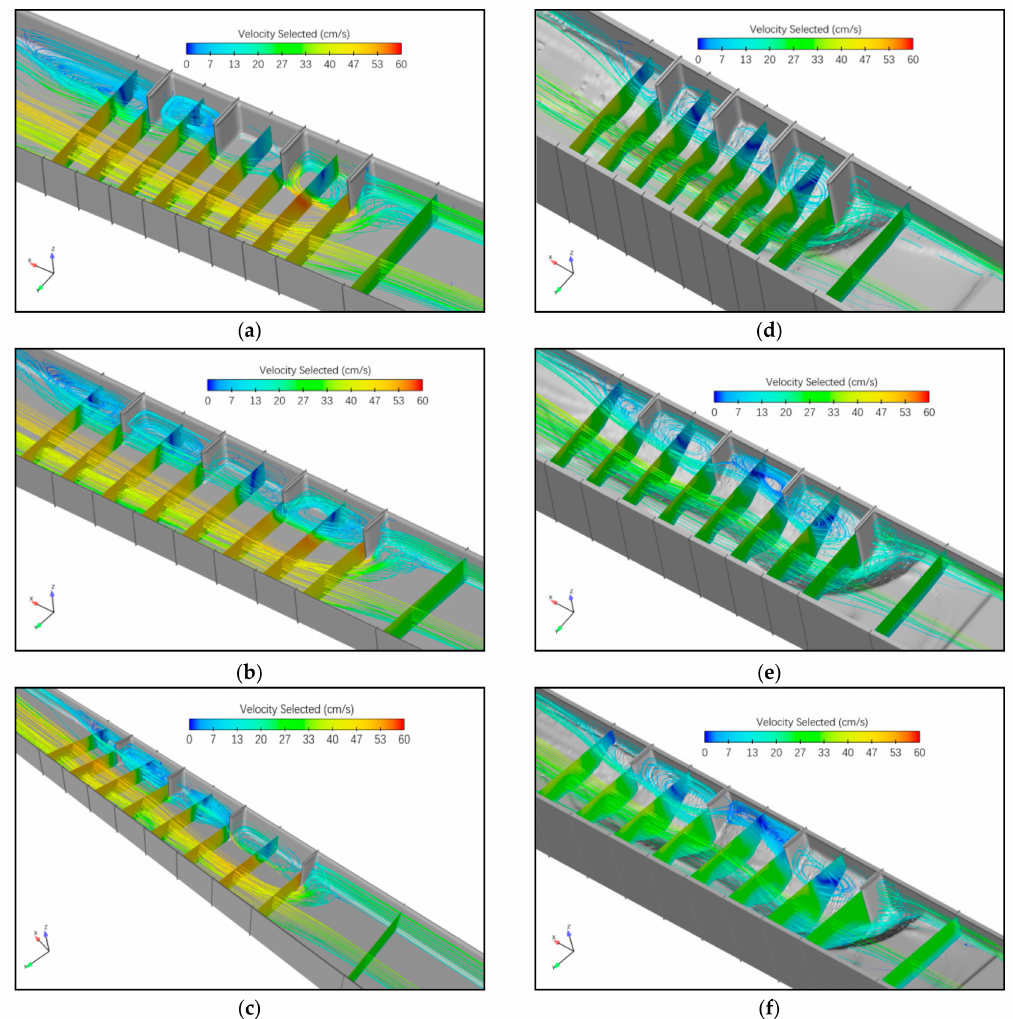
Figure 7. The velocity magnitude contours and the streamline diagrams of di ff erent spur dike spacing. ( a ) fixed bed for 2 l spacing; ( b ) fixed bed for 3 l spacing; ( c ) fixed bed for 4 l spacing; ( d ) movable bed for 2 l spacing; ( e ) movable bed for 3 l spacing; ( f ) movable bed for 4 l